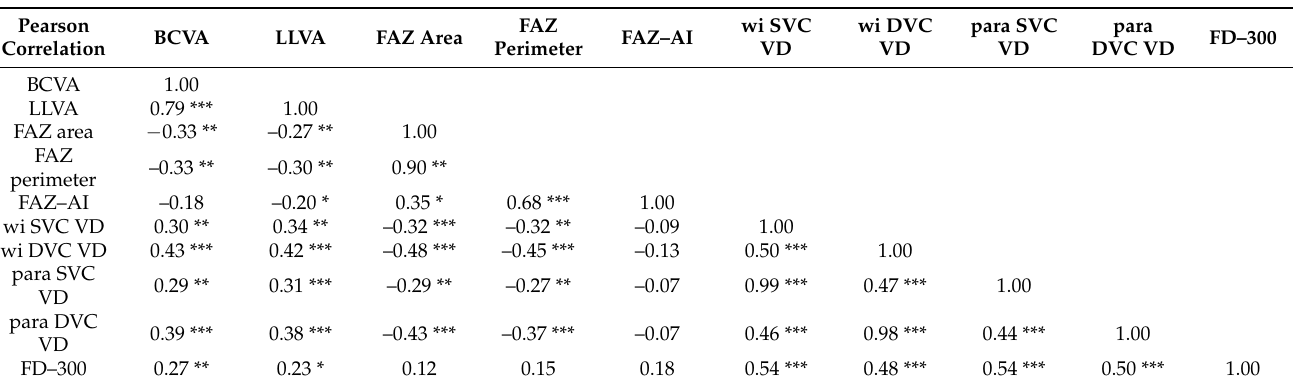
Table 2. The correlation between different optical coherence tomography angiography parameters in the 3 × 3 mm scan